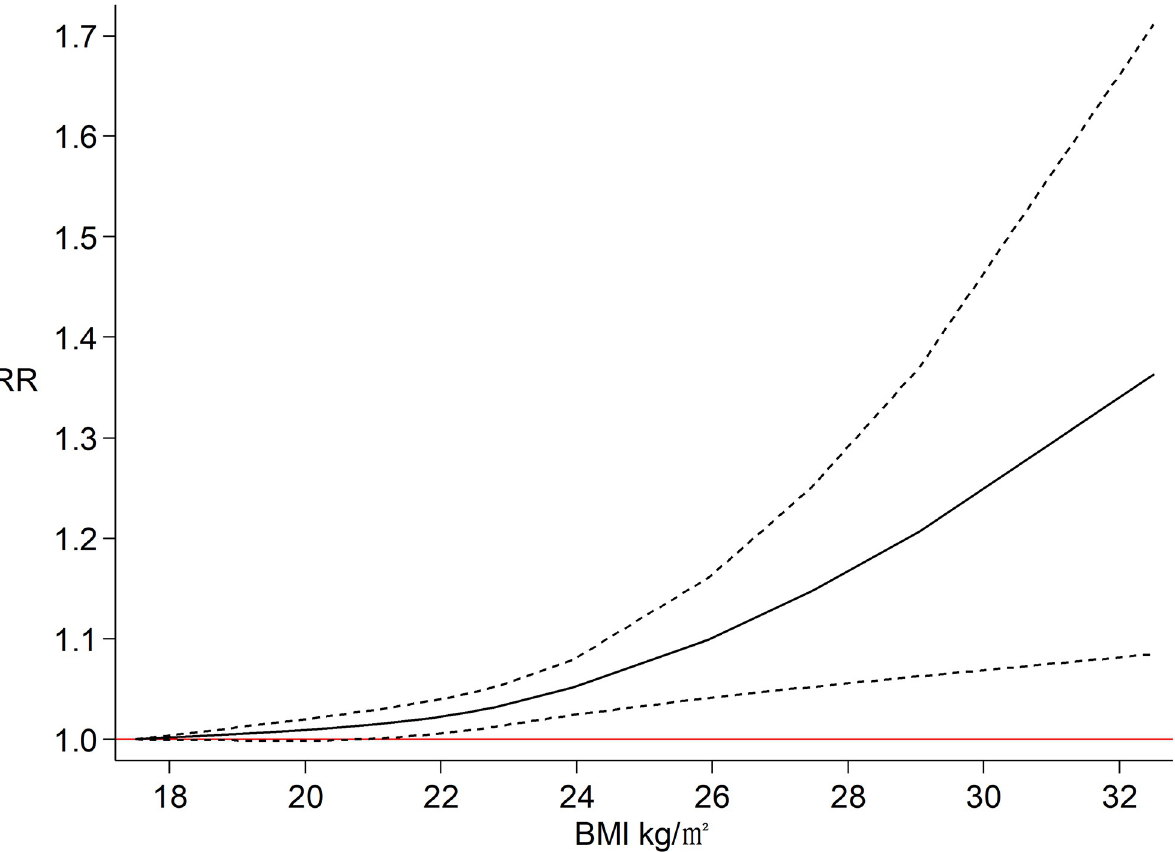
Fig 3. The dose–response plot for the association of obesity in children and adolescents with ovarian cancer.